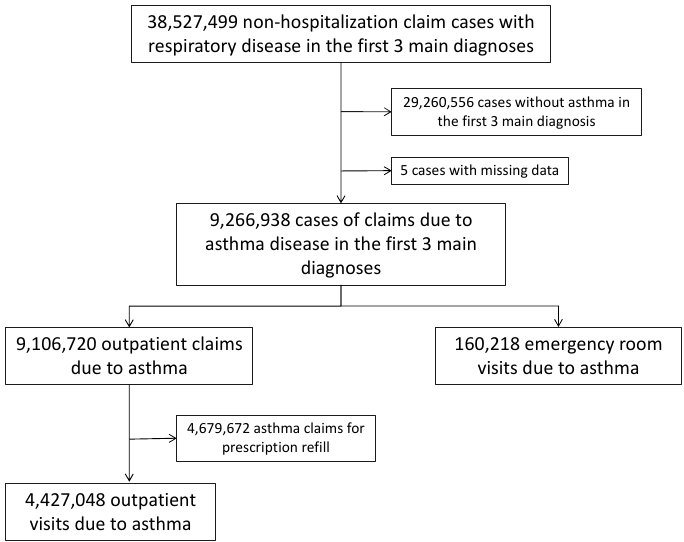
Figure 1. Flow diagram of patient inclusion and exclusion in this study.